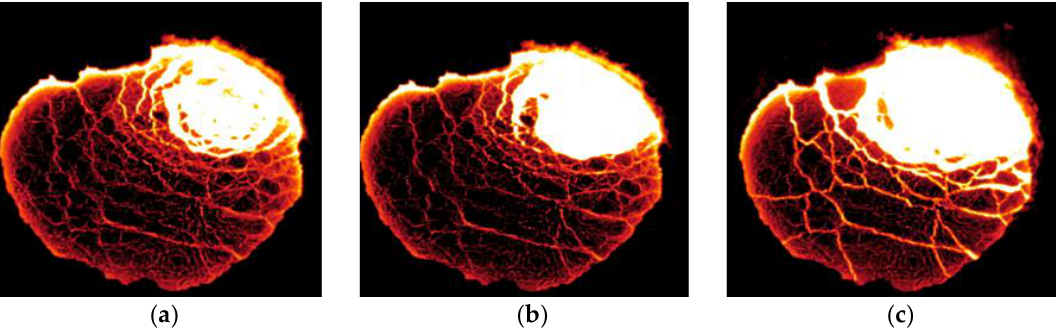
Figure 2. Open-eye size in the ladle from experimental results ( Z = 3.37 m): ( a ) Q = 100 NL/min, ( b ) Q = 300 NL/min, and ( c ) Q = 500 NL/min.